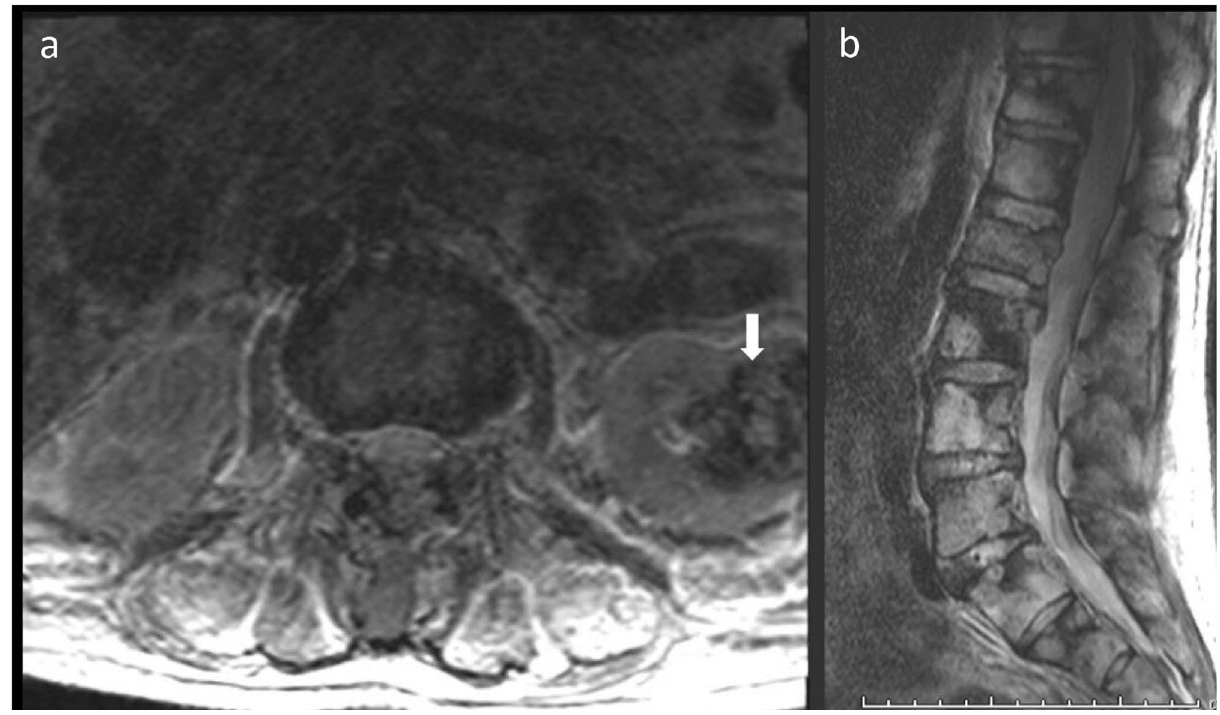
Figure 1. A 75-year-old male patient with left renal cell carcinoma and spine metastasis. ( a ) Axial T2 weighted images showing a heterogenous solid left renal mass (white solid arrow). ( b ) Sagittal T2 weighted images showing diffuse spinal